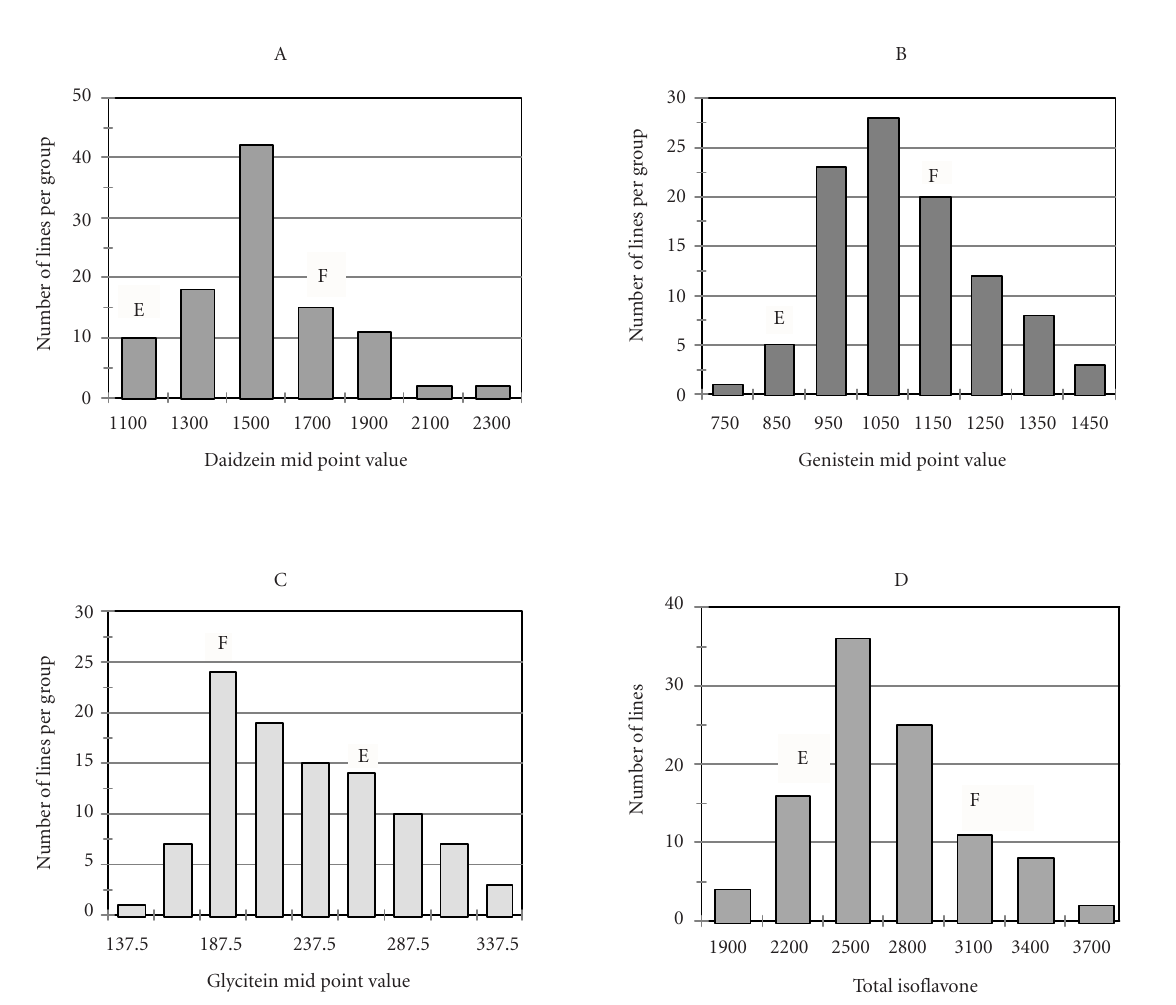
Figure 1: Frequency distributions of the mean isoflavone content across two locations among 96 recombinant inbred lines from a cross between cultivars Essex and Forrest. The mean isoflavone content for each parent is shown. A, daidzein content. B, genistein content. C, glycitein content. D, Total isoflavone. The isoflavone content is calculated in µ g/g of dry weight of soybean seed.